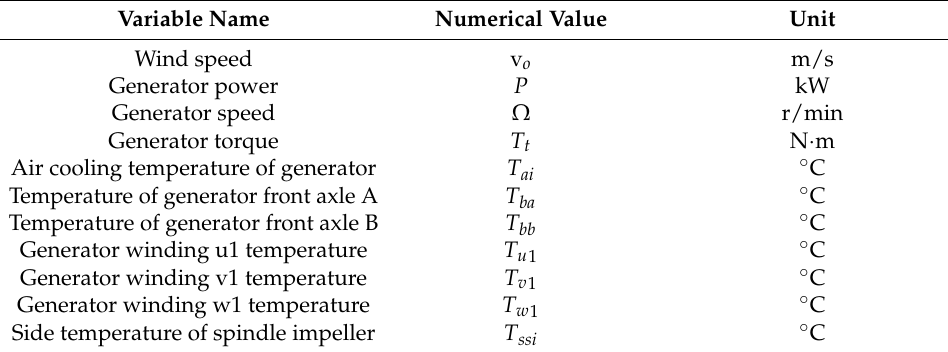
Table 2. Description of generator condition variables.